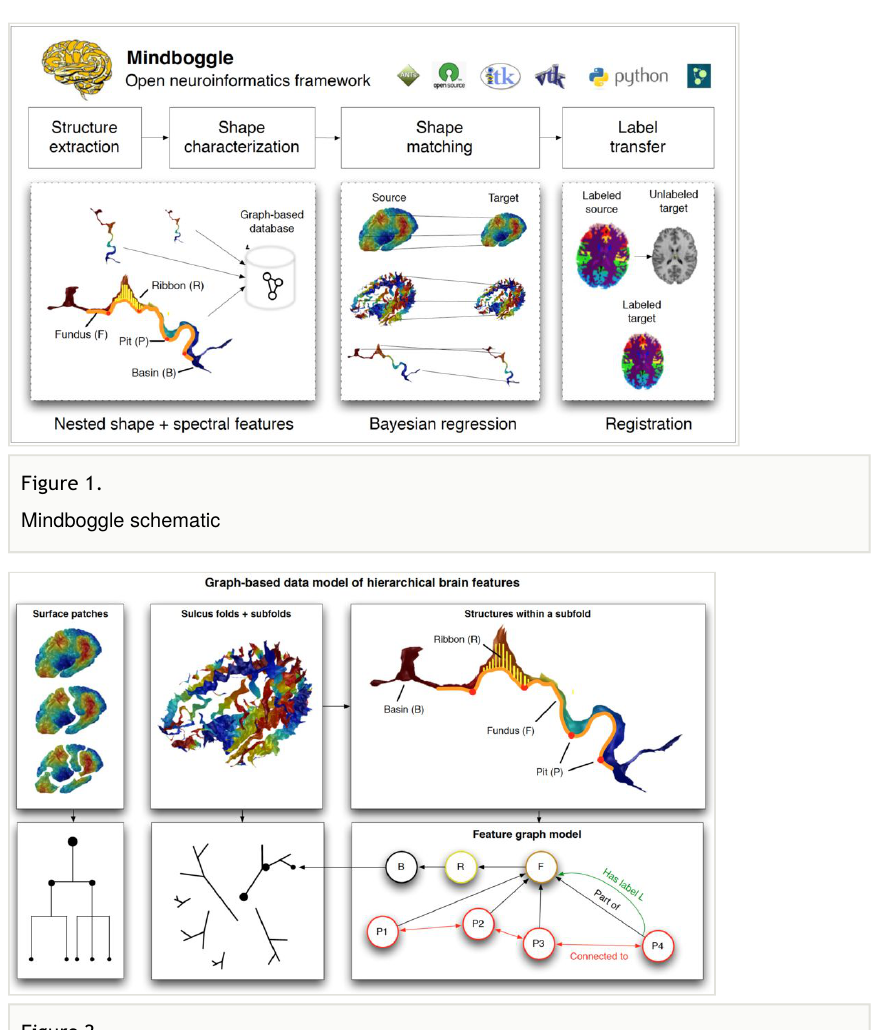
Schematic of Mindboggle’s graph-based database of anatomical features. Top: di ff erent structures derived from brain images: surface patches fragmented by application of the Laplace-Beltrami operator, sulcus folds and subfolds, and structures within a subfold. Bottom: schematic graph diagrams representing the relationships among the nested structures. Bottom right: examples of features as properties of edges (relationships such as Part of, Connected to, Has label) and nodes (geometric, shape, and spectral